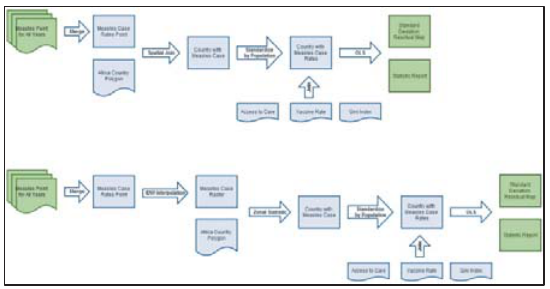
Figure 1. Methodology for OLS